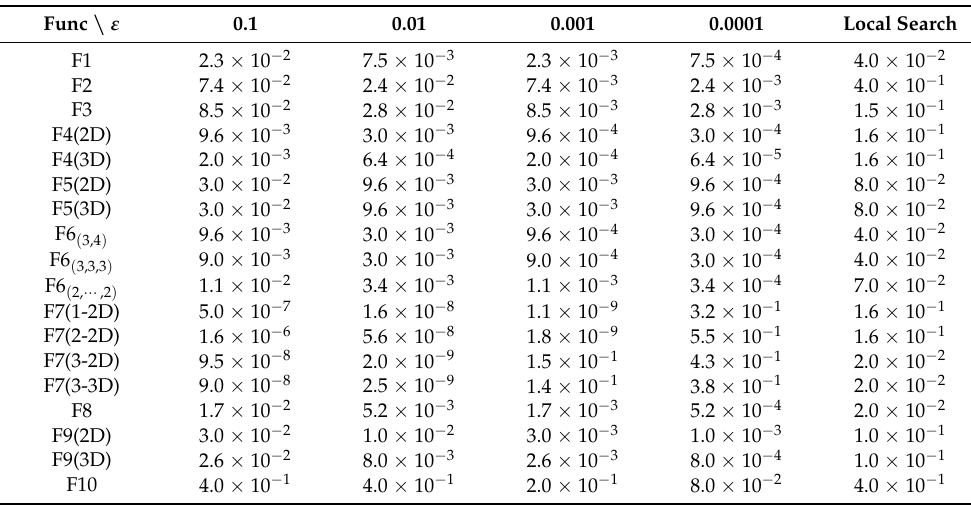
Figure A1. The surface plots of the selected benchmark functions. f 4 , f 5 , f 6 , f 7 , f 9 only show 2D cases. Table A1. The edge threshold of nonpartitionable